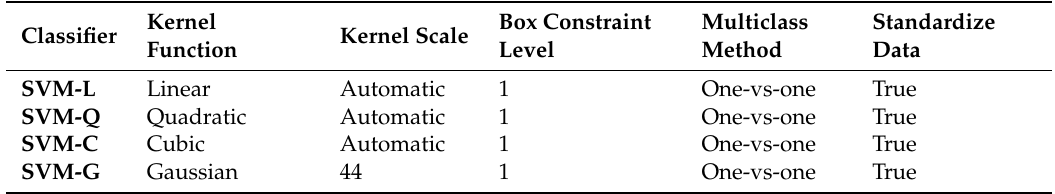
Table 3. Parameters of selected